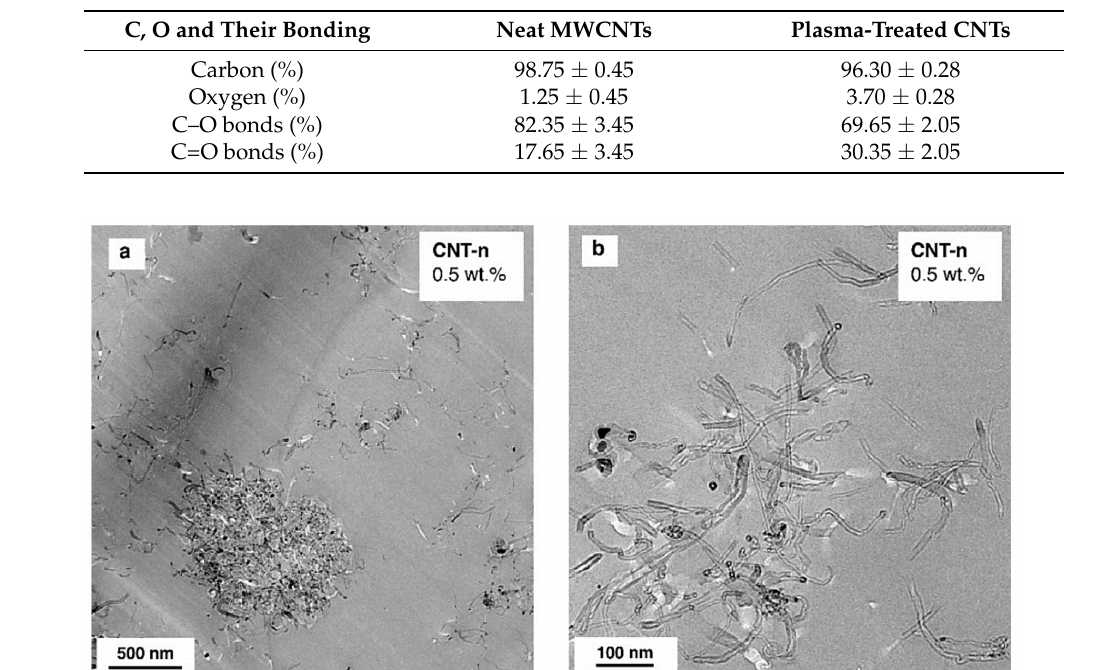
Table 1. X-ray photoelectron spectroscopy of neat and plasma-treated MWCNTs.